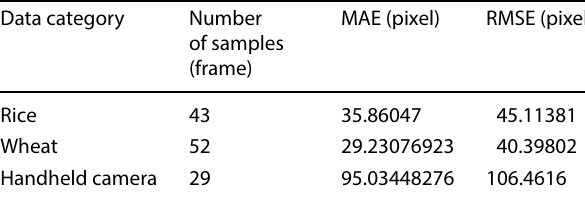
Table 1 Crop height boundary extraction